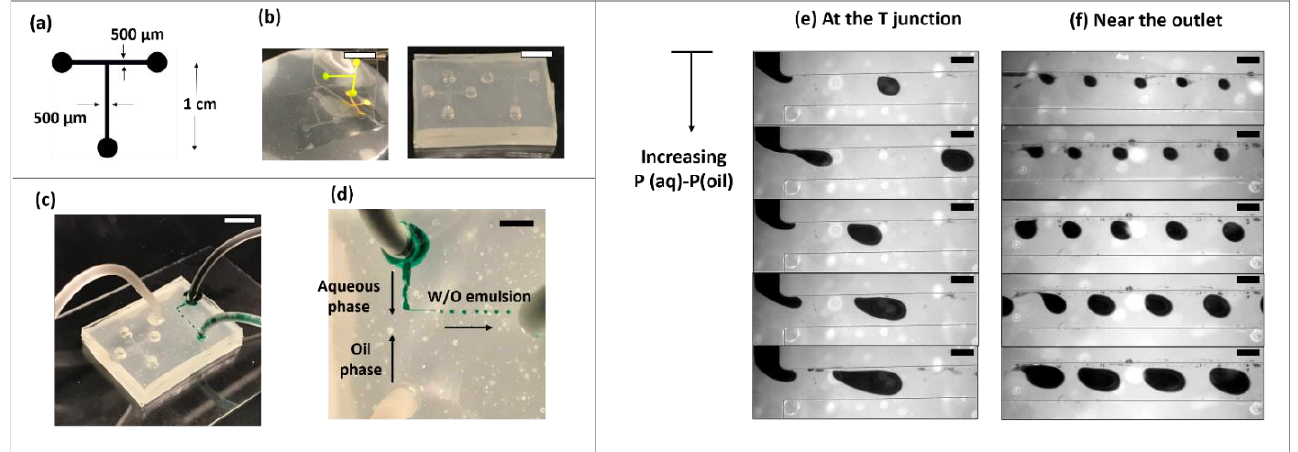
Figure 7. A water-in-oil emulsion generator microchip. ( a ) A CAD input file to the vinyl cutter showing the dimensions of the T junction. ( b ) The resulting silicone microfluidic chip from the wet paper mold. ( c ) Image showing the experimental set up where two fluids were flowed into the chip using gravity driven flow. ( d ) A zoomed-in view of the T junction showing the formation of water in mineral oil emulsions. Pressure difference between the two inlets was varied by changing the column height. Images showing microscopic view at the junction ( d ) and near at the outlet ( e ) can be seen where droplet sizes increase as a function of increasing pressure difference. For this demonstration, the column height of oil was maintained at the same level whereas the aqueous inlet column height was varied to modulate the pressure differential. The scale bars represent 5 mm for images in ( b – d ), while for all the images in ( e , f ), it is 250 µm.